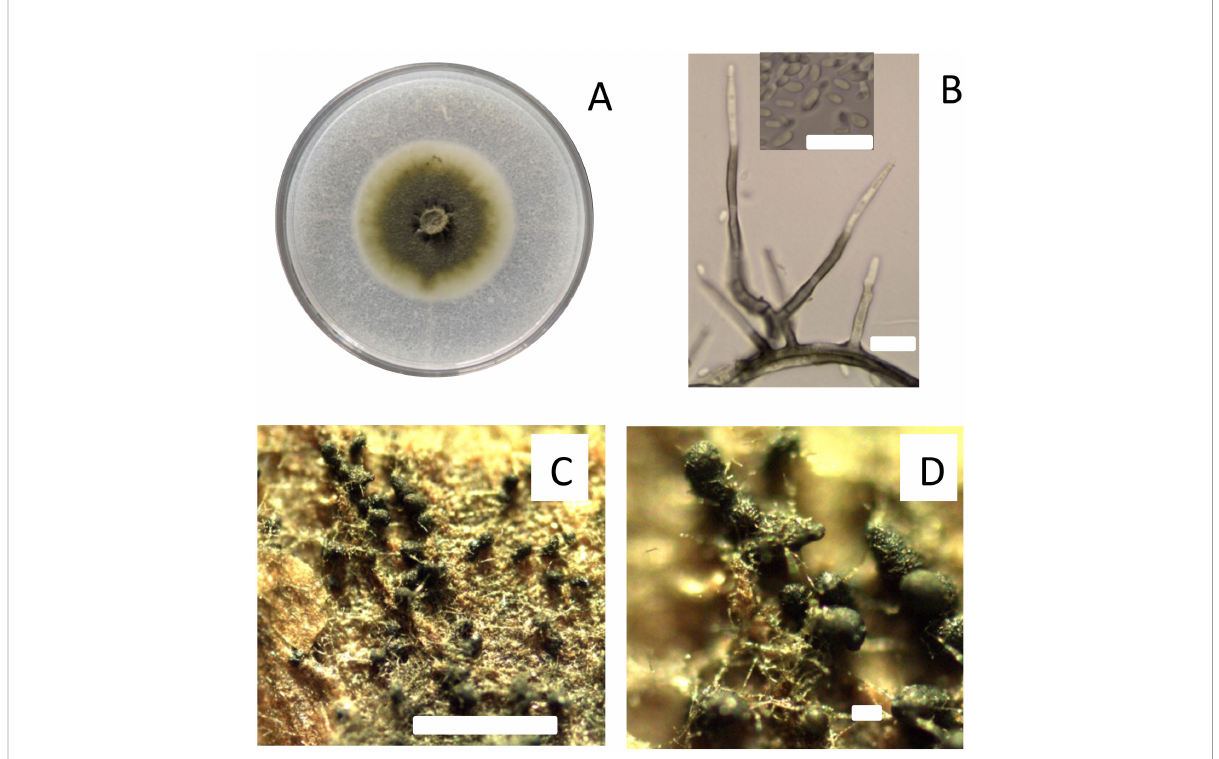
FIGURE 1 Characteristics of isolate Pach 3 of Phaeomoniella chlamydospora studied as fungal trunk pathogen on the susceptibility of pruning wound of different ages of Cabernet Sauvignon in central Chile. Colony of P. chlamydospora after 21 days incubated at 25°C on PDA media (A) . Morphological characteristics of P. chlamydospora as conidiophores and conidia (B) . Inoculum of pycnidia of P. chlamydospora induced on autoclaved grapevine wood chips on WA media (C, D) . All bars = 10 um, except C and D with bars of 200 um and 1000 um,